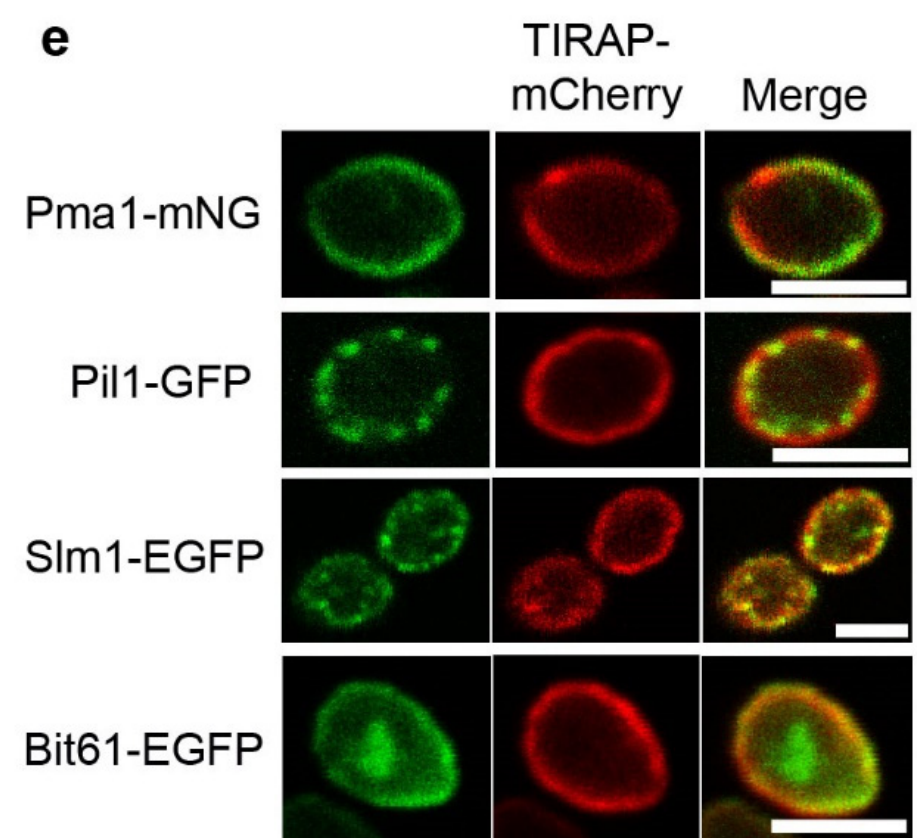
Figure 1. Human TIRAP localizes to the PM in yeast cells. ( a ) Differential interference contrast and fluorescence microscopy of YPH499 yeast cells expressing mCherry- TIRAP from pYES2 (red) and CDC10 -GFP from pLA10H (green). ( b ) Four different focuses of the same cell expressing mCherry- TIRAP from pYES2. Focus on the cell surface allows visualization of short filaments (leftmost image) that in the middle plane often appear as spots (right). ( c ) Selected laser confocal microscopy of YPH499 yeast cells expressing TIRAP -mCherry from pYES3 (red) and GFP-PH( PLC δ ) (PH-PLC) from pRS426, a PtdIns(4,5)P 2 marker (green). In contrast to PH-PLC, TIRAP-mCherry is missing from the emerging bud area (upper panel), as well as from the bud neck both in small- (middle panel) and large-budded (lower panel) cells (arrowheads). The middle panel shows a typical cell in which the TIRAP-mCherry signal is fainter in the emerging bud than in the mother cell. ( d ) Different confocal planes of a representative cell as in ( c ), showing a differential PM pattern for the green (PH-PLC) and red (TIRAP-mCherry) channels. ( e ) Laser confocal microscopy of yeast cells expressing TIRAP -mCherry from pYES3 (red) and displaying different membrane compartments tagged in green: the MCP (Membrane Compartment containing Pma1) component Pma1-mNG (from EVY3 yeast strain), the MCC (Membrane Compartment containing Can1) component Pil1-GFP (from TWY110 yeast strain), the MCC/MCT (Membrane Compartment containing TORC2) component Slm1-EGFP (from a pAG413GPD derived plasmid), and the MCT component Bit61-EGFP (from a pAG413GPD derived plasmid). Scale bars correspond to 5 µ